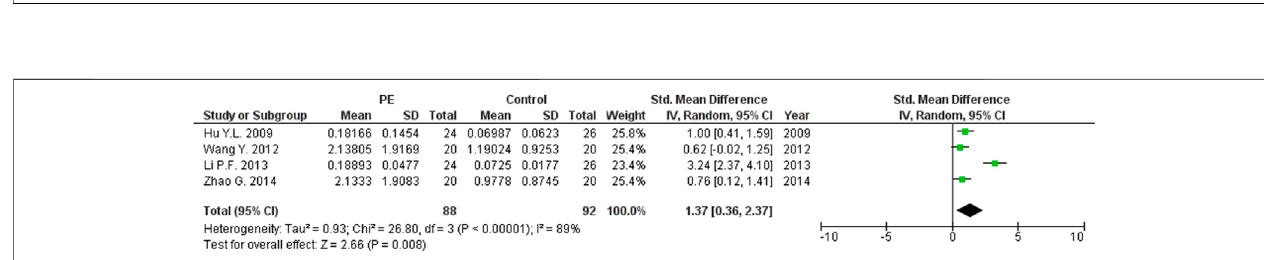
FIGURE 4 | Meta-analysis of differences in expression level of miRNA-23a in placenta between women with vs. without preeclampsia.